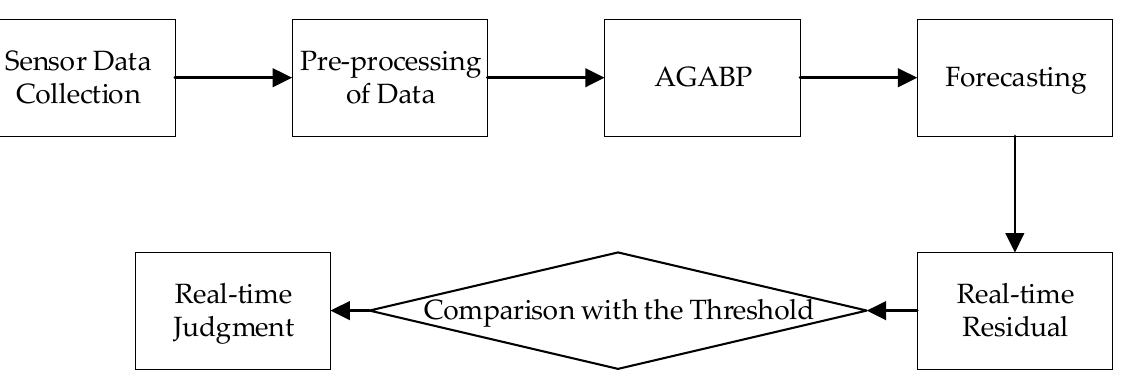
Figure 5. The diagnosis process of AGABP.